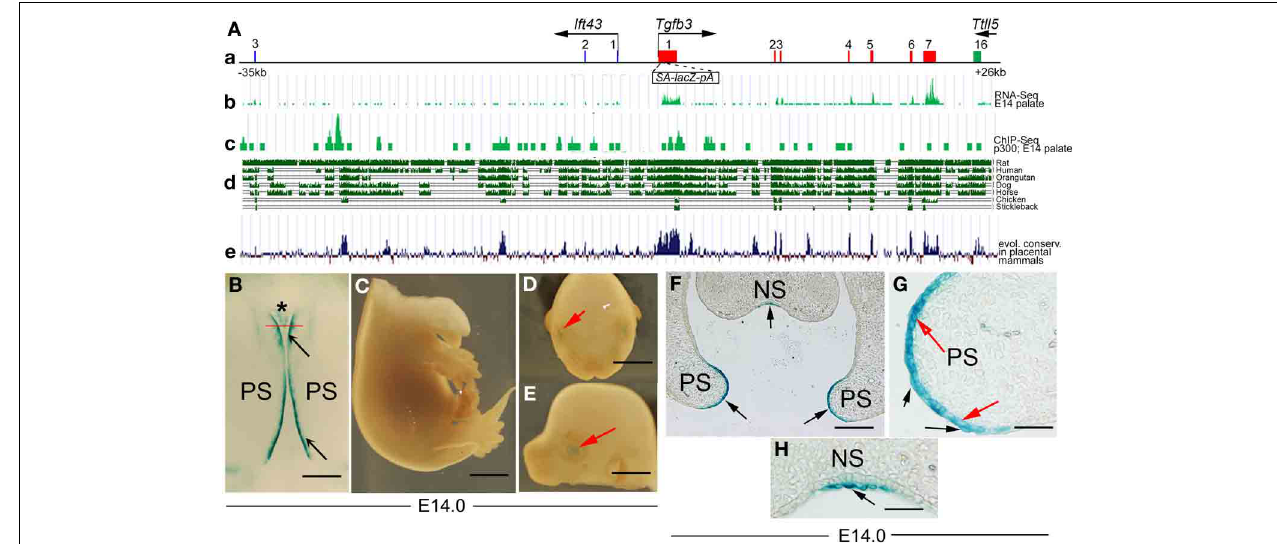
FIGURE 4 | A 61-kb genomic region including the Tgfb3 gene targets reporter activity to the MEE and adjacent periderm. (A) Schematic representation of the 61-kb region (see main text) includes (a) the Tgfb3 gene (exons in red); exons 1–3 of the Ift43 gene (blue boxes) and exon 16 of the Ttll5 gene (green box). That Tgfb3 but neither of its neighbors is actively expressed at E14.5 is shown in (b) , RNA-seq profile in mouse palate at E14.5—(FaceBase Enhancer Project; A Visel). Different types of sequence analysis are suggestive of possible enhancer sites: (c) p300 Chip-seq profile in mouse palate at E14.5 (ref: FaceBase Enhancer Project; A Visel), (d) evolutionary sequence conservation among selected vertebrate species in this sequence (UCSC genome browser) and (e) evolutionary sequence conservation among placental mammals (UCSC